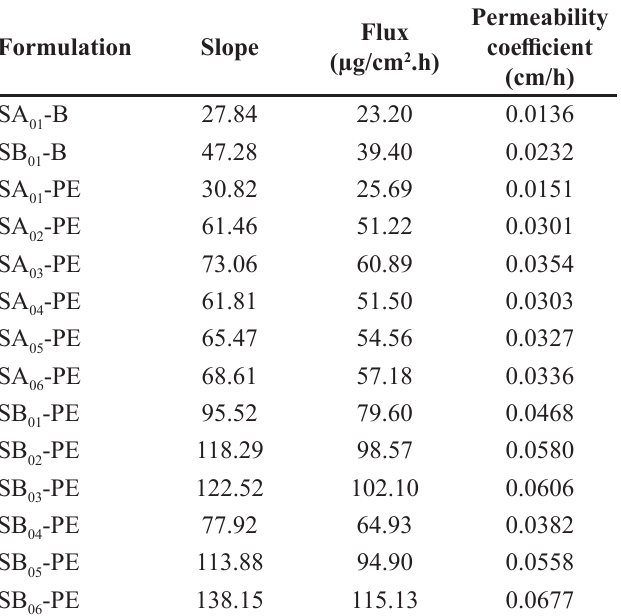
TABLE V - Slope, flux and permeability coefficient of formulations containing permeation enhancer